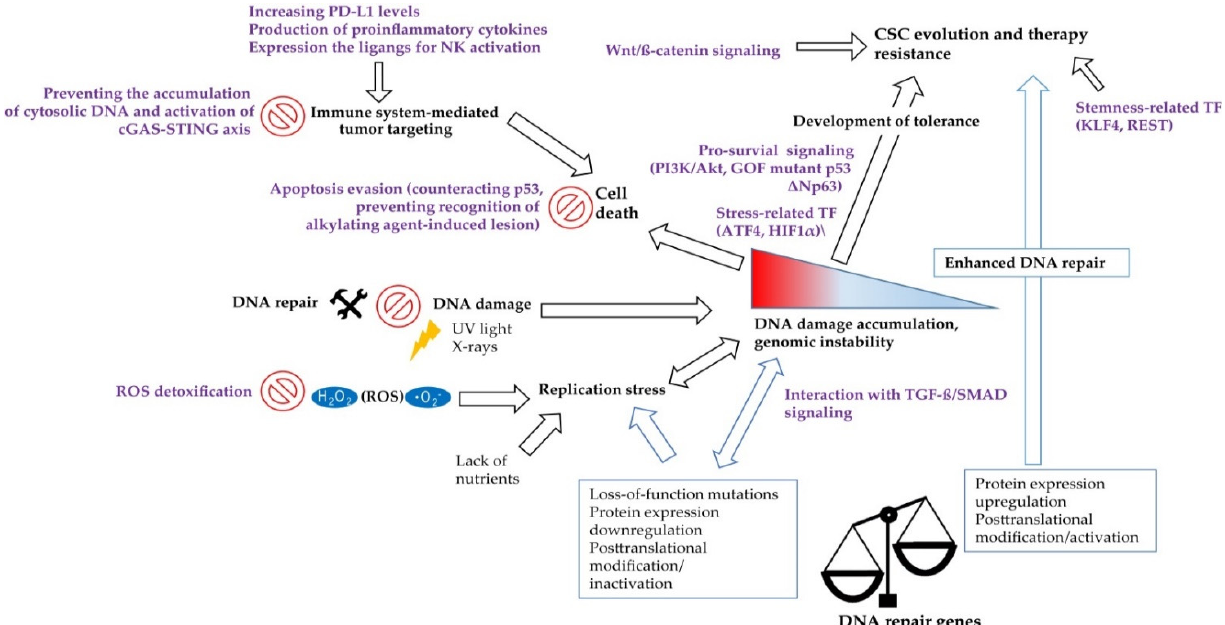
Figure 1. Canonical and non-canonical role of DNA repair proteins in the cancer stem-cell (CSC) phenotype. The dysregulated expression and activation of DNA repair proteins influence CSC evolution and therapy resistance via. their canonical function in the repair of exogenous and endogenous DNA damage and the prevention of replication stress (blue boxes/arrows). Their multiple non-DNA repair-related roles include interaction with CSC signaling and stemness-related transcription factors (TF), reactive oxygen species (ROS) detoxification and immune evasion (violet). Akt—Protein kinase B; ATF4—Stress-related activating transcription factor 4; cGAS—GMP—AMP synthase; GOF—Gain-of-function mutant; HIF1 α —Hypoxia-inducible factor 1 alpha; KLF4—Krüppel-like factor 4; PI3K—Phosphatidylinositol-3-kinase; NK— Natural killer cells; PD-L1—Programmed death-ligand 1 (PD-L1); REST—Repressor element 1 silencing transcription factor; SMAD3—Mothers against decapentaplegic homolog 3; STING—stimulator of interferon genes; TGF-ß—Transforming growth factor-beta; Wnt—Wingless/integrated; ∆ Np63—p63 isoform lacking N-terminal